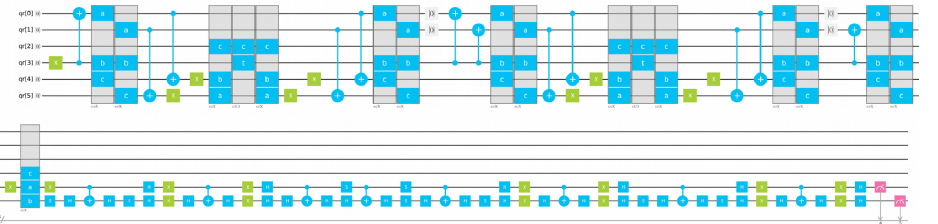
Figure 5: Integral (storage and recall) topological requirements for (from left to right) 2-bit,